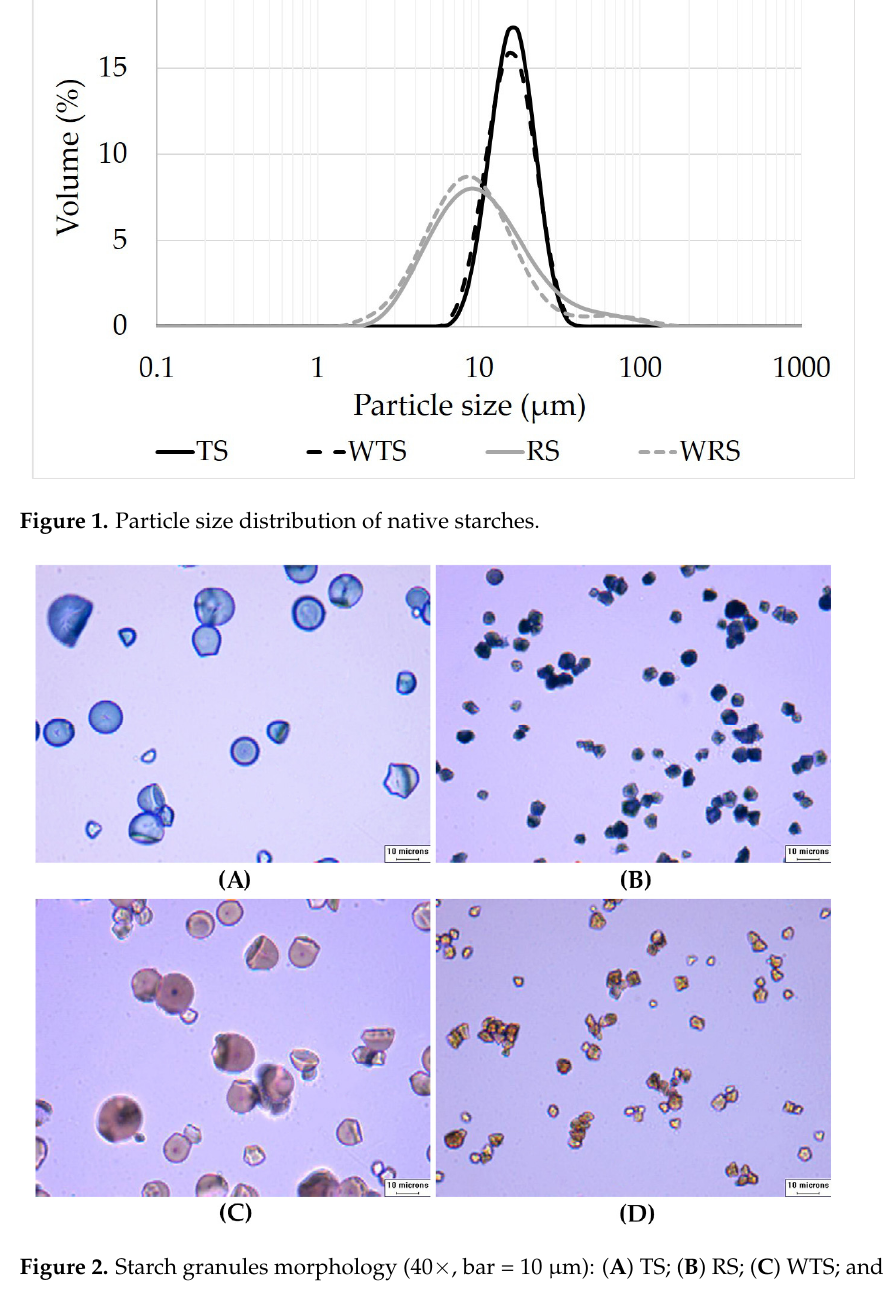
Figure 2. Starch granules morphology (40×, bar = 10 μ m): ( A ) TS; ( B ) RS; ( C ) WTS; and ( D ) WRS.